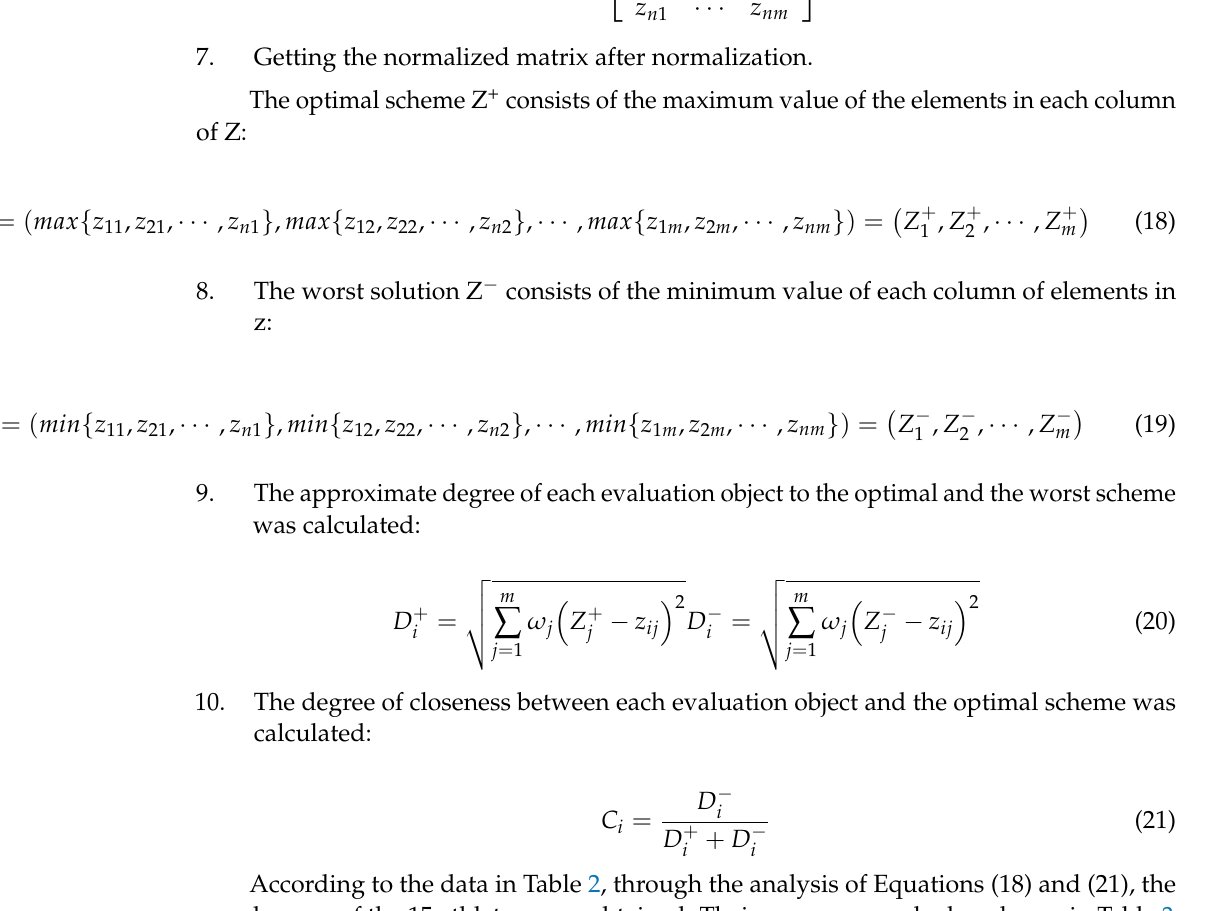
According to the data in Table 2, through the analysis of Equations (18) and (21), the speed scores of the 15 athletes were obtained. Their scores are ranked as shown in Table